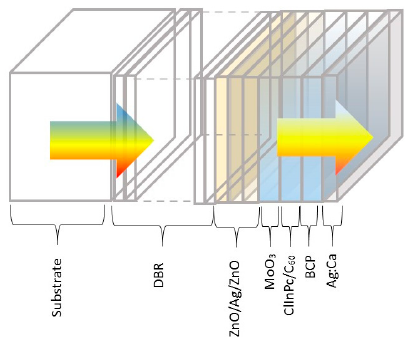
Figure 1. Schematic of the transparent solar cell.